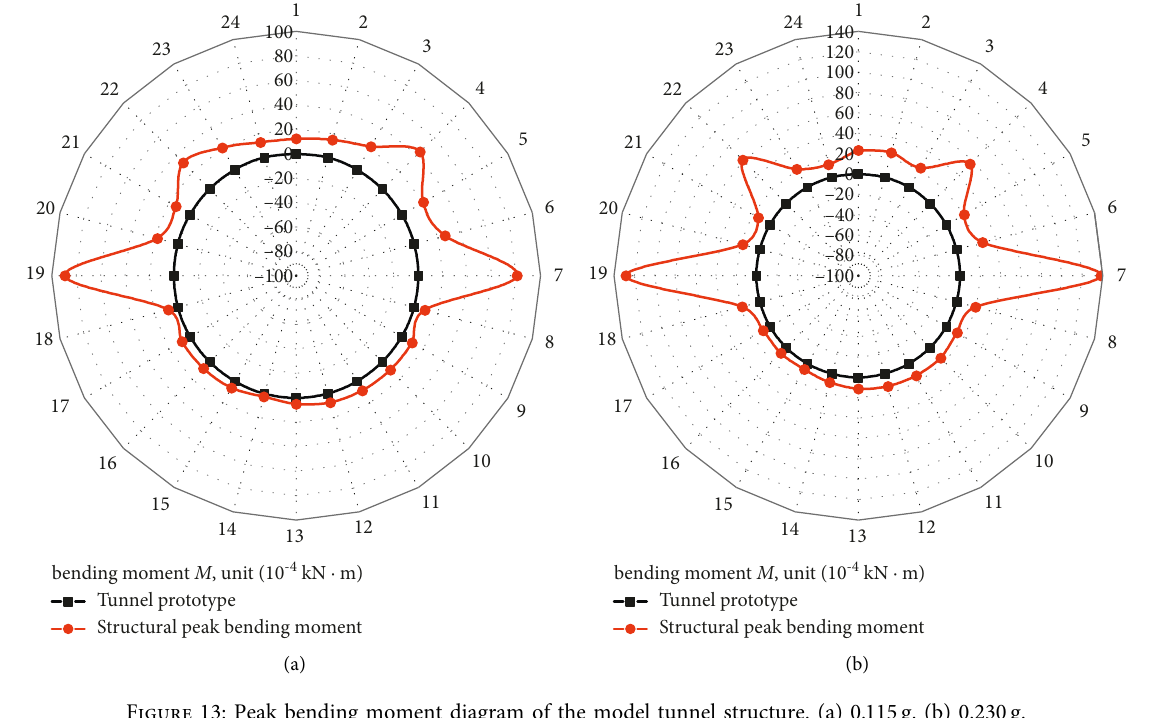
Figure 13: Peak bending moment diagram of the model tunnel structure. (a) 0.115 g. (b) 0.230g.